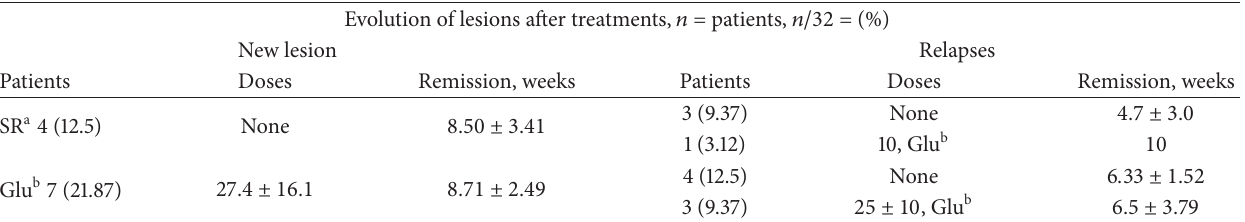
Table 3: Evolution of lesions in patients ( 𝑛 = 32 ) with cutaneous leishmaniasis secondary infections. Evolution of lesions after treatments, 𝑛 = patients, 𝑛/32 = (%) New lesion Relapses Patients Doses